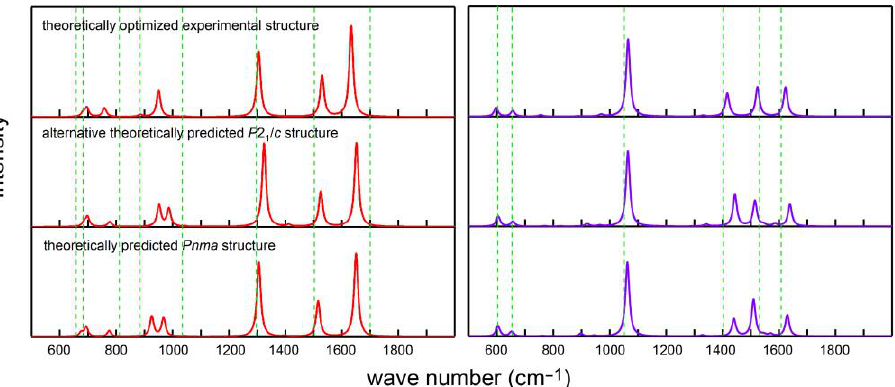
Figure 6. Calculated infrared ( left ) and Raman ( right ) spectra of H 2 CO 3 at a pressure of 2 GPa. For comparison, the positions of the experimentally determined vibrations under ambient-pressure conditions [59] are indicated as dashed green lines. O – H stretching vibrations appear at higher wavenumbers and have not been included.